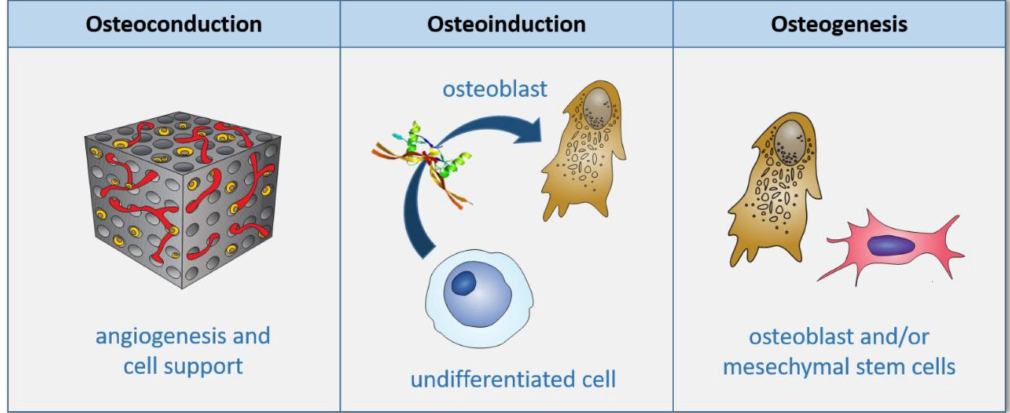
Figure 6. Diagram showing mechanisms of osteoconduction, osteoinduction, and